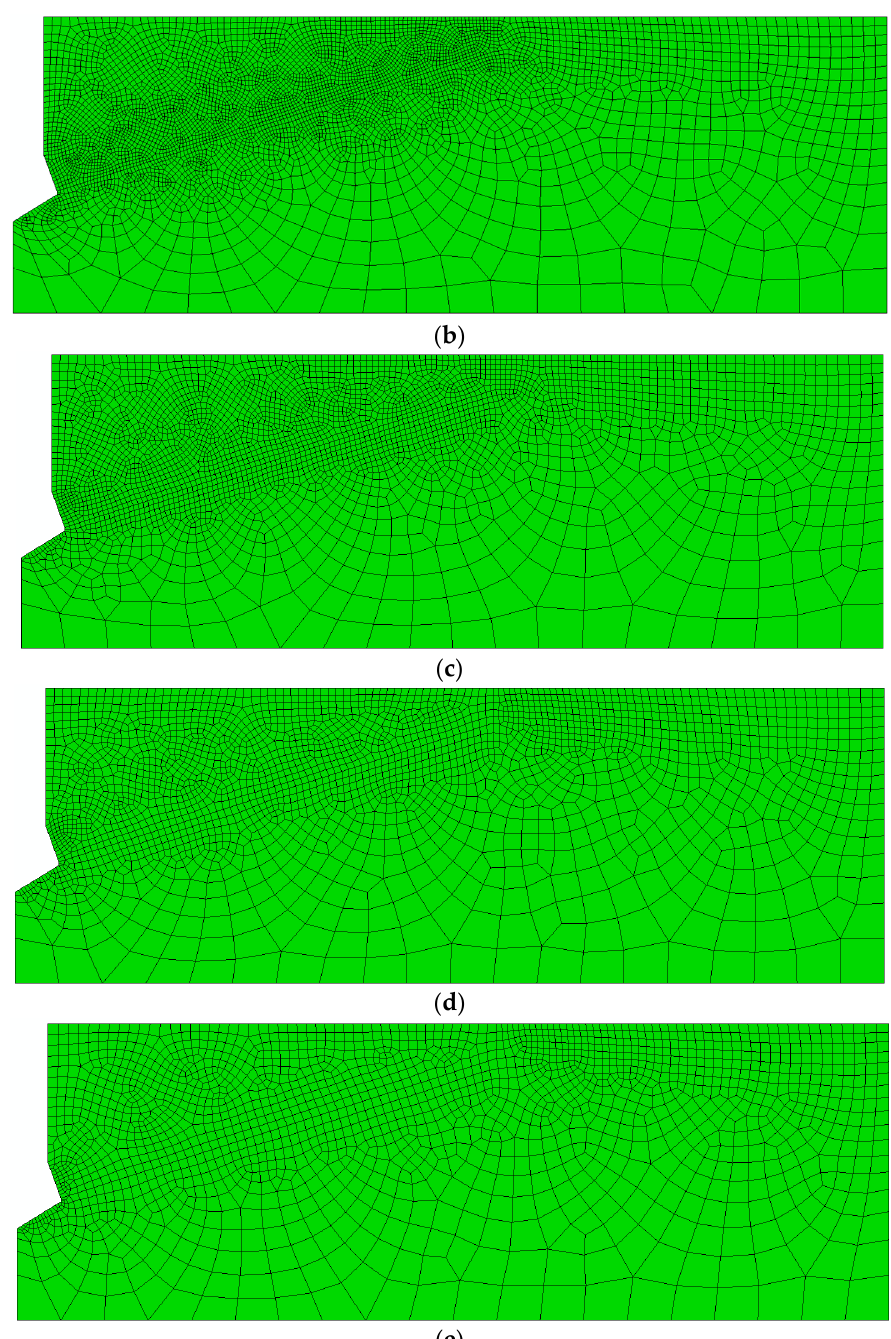
Figure 3. Finite element mesh of the model with compaction in the area of the hypothetical propagation of the “cone” of destruction. The different densities of the mesh along the expected crack line: ( a ) 1 mm, ( b ) 2 mm, ( c ) 3 mm, ( d ) 4 mm, and ( e ) 5 mm. The restraints to the nodes of the finite element mesh of the model (Figure 4) were made in the axis of the model (under the anchor) and along the bottom (horizontal) and outermost sides of the model. For the most part, the restraints were stripped of all degrees of freedom axis (the Y axis of the (U1 = U2 = U3 = 0).